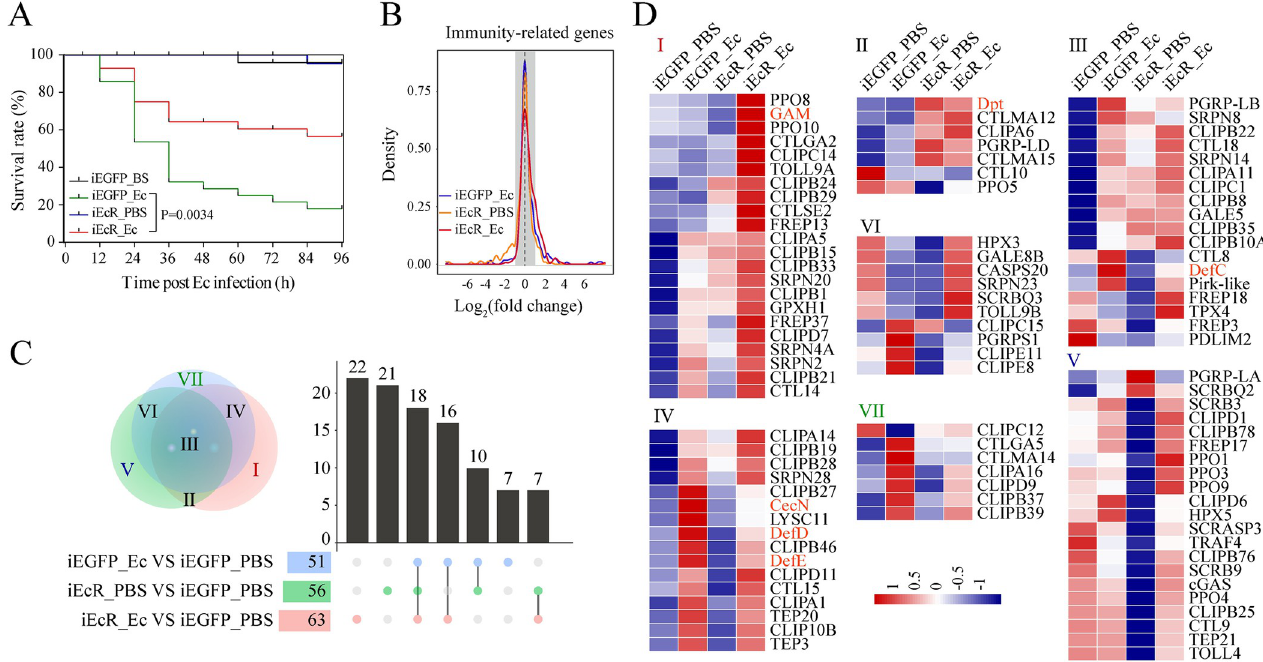
Fig 2. Silencing of EcR increases susceptibility to infection and induces IMRG expression. (A) Survival of EcR knockdown (iEcR) or control (iEGFP) mosquitoes after E . cloacae infection. n = 3 cohorts (total 90 mosquitoes). P values for differences in survival times between iEGFP and iEcR mosquitoes were determined by means of the log-rank test. (B) Density plot showing the effect of EcR silencing (iEcR) on IMRG expression after E . cloacae or PBS treatment. Gray shaded area indicates values used to define differentially expressed genes or resistant genes. (C) Venn diagram and UpSet plot representing unique and shared IMRGs. The overlapping regions represent gene cohorts that are concomitantly regulated by one or two experimental conditions. (D) Hierarchical cluster analysis of IMRGs in (C) with log 2 (FPKM) values. Gene names are shown on the right. Data are from three biological replicates. Pearson correlation > 0.97 for all